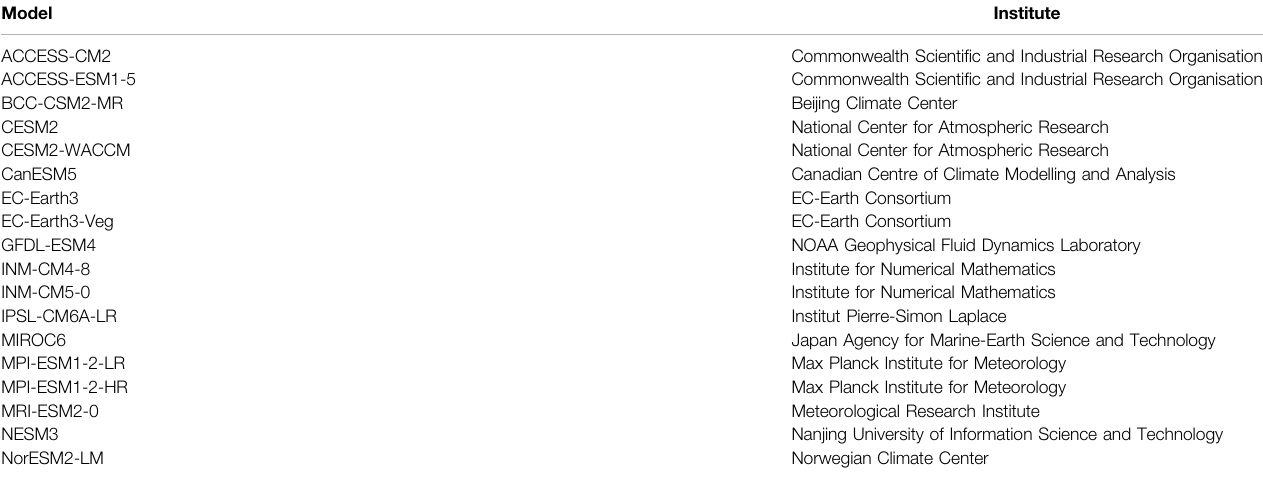
TABLE 1 | Output is used from the following models from phase six of the Coupled Model Intercomparison Project.